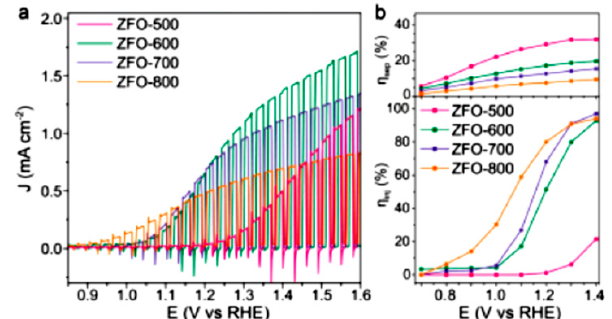
Figure 14. The performance of ZnFe 2 O 4 (ZFO) photoanodes. ( a ) Linear scanning J–V curves in 1 m NaOH under 100 mW·cm − 2 illumination; ( b ) Calculated charge separation efficiency, η sep , and minority charge carrier injection efficiency, η inj . Reprinted with permission from ref. [42]. Copyright 2018. Wiley. Table 1. The hole diffusion length of different materials.